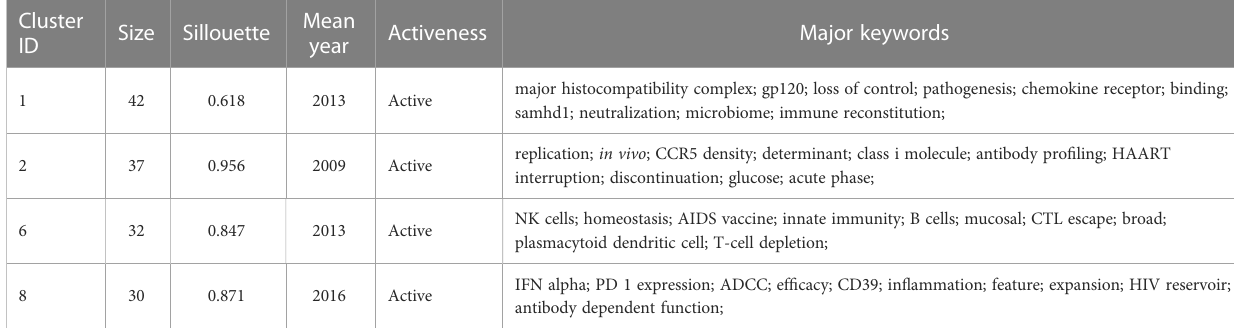
TABLE 6 Detailed information on active keyword clusters in the elite controller fi eld. Cluster ID